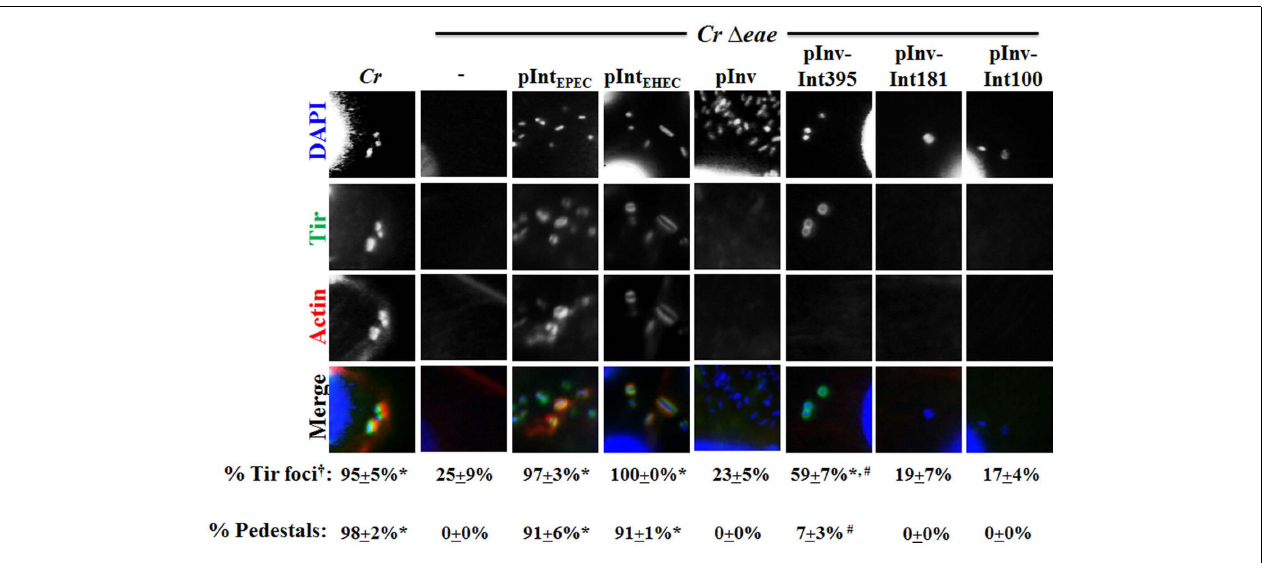
FIGURE 5 | Enterohemorrhagic E. coli intimin, but not aTir-binding invasin–intimin hybrid, promotesTir clustering and pedestal formation by C. rodentium . Monolayers were infected with the indicated C. rodentium (“ Cr ”) strains and stained with DAPI to visualize bacteria (blue), anti-EHECTir antibody (green), and fluorescent phalloidin (red) to detect F-actin.Twenty-five bound bacteria were scored for their association withTir foci or pedestals. † Note that when quantifying the percentage of cells